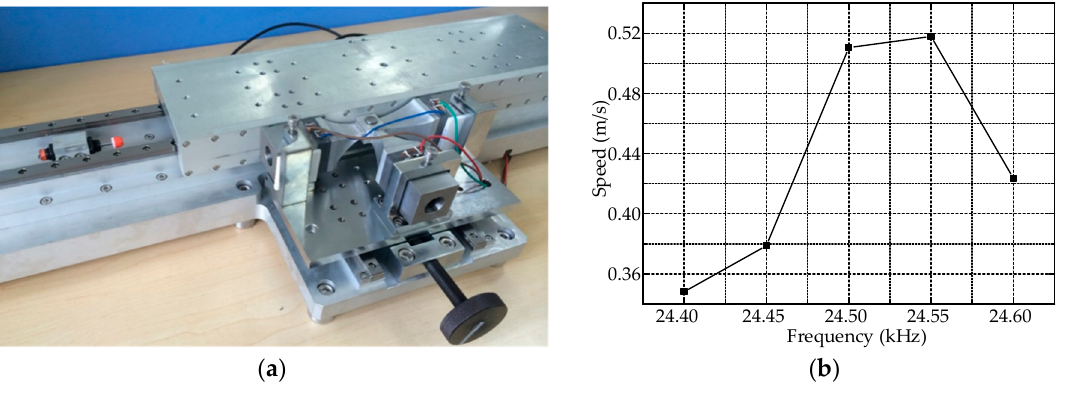
Figure 8. Experimental platform structure diagram: ( a ) The 3D model of general linear ultrasonic motor experimental platform; ( b ) The side ‐ view of general experimental platform. 1. thrust spring; 2. stator mounting plate; 3. Motor; 4. motor mounting bracket; 5. friction material installation plate; 6. load sliding table; 7. guide rail installation pedestal; 8. inertia load block; 9. guide rail sliding block; 10. reading head; 11. grating scale; 12. experimental platform pedestal.